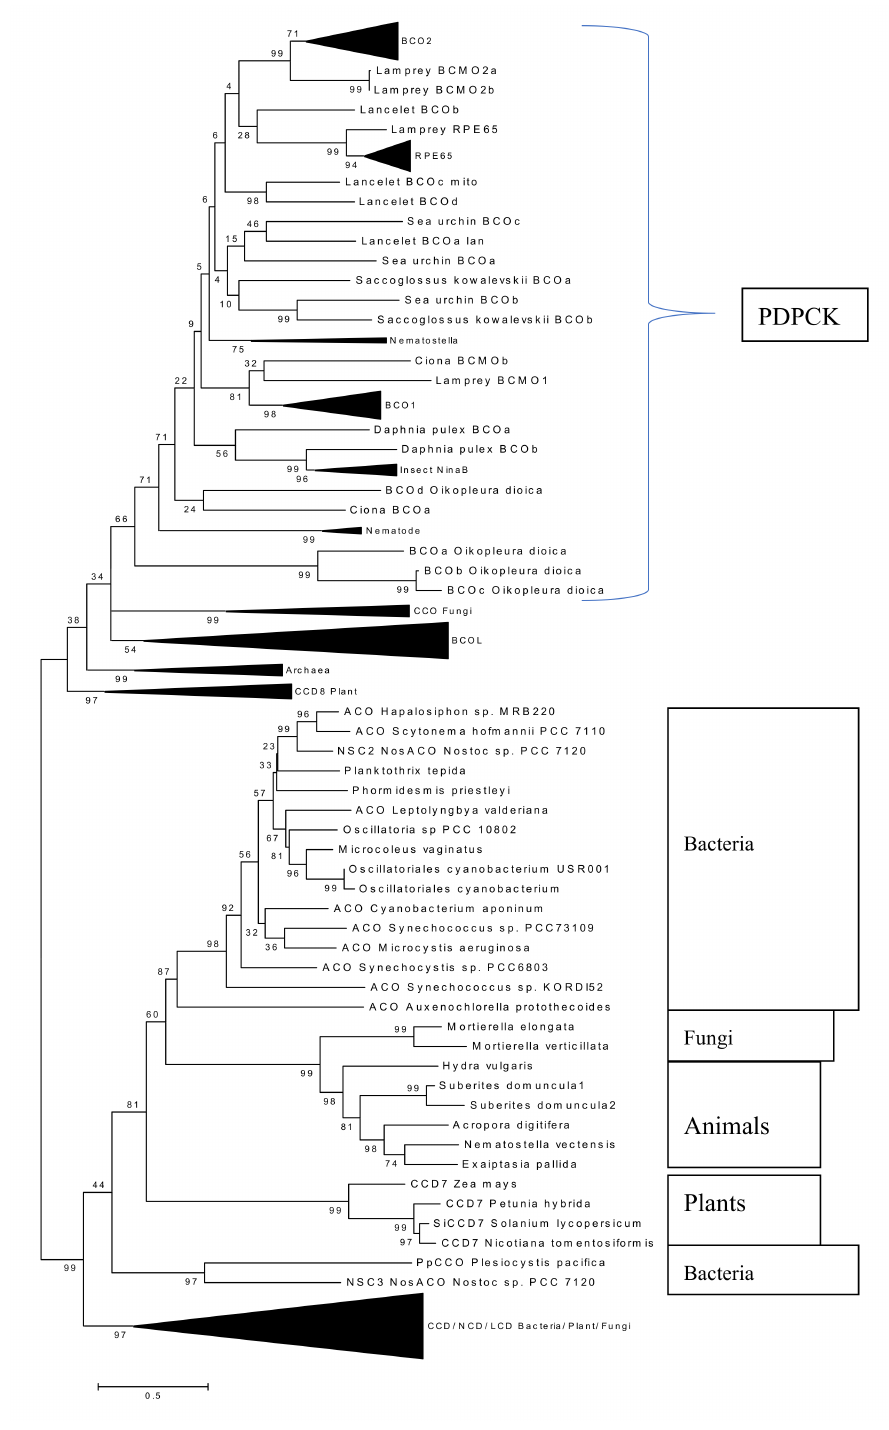
Figure 6. Molecular Phylogenetic analysis of the oxygenase superfamily by Maximum Likelihood (ML) method. The tree with the highest log likelihood ( − 10405.24) is shown. The percentage of trees in which the associated taxa clustered together (bootstrap support) is shown next to the branches. Initial tree(s) for the heuristic search were obtained automatically by applying Neighbor-Join and BioNJ algorithms to a matrix of pairwise distances estimated using a WAG (Whelan-and-Goldman) model, and then selecting the topology with superior log likelihood value. A discrete Gamma distribution was used to model evolutionary rate di ff erences among sites (2 categories ( + G, parameter = 1.1990)). The tree is drawn to scale, with branch lengths measured in the number of substitutions per